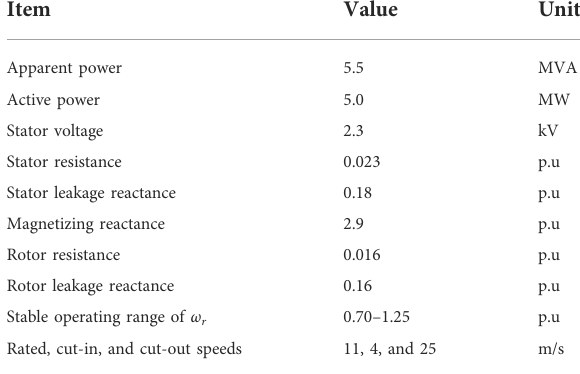
TABLE 1 Parameters of the